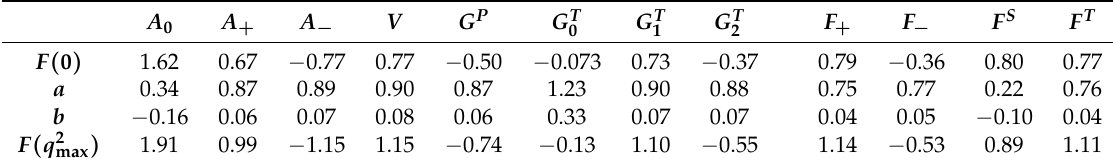
Table 1. Parameters of the dipole approximation in Equation (37) for B 0 → D ( ∗ ) form factors. Zero-recoil values of the form factors are also listed.